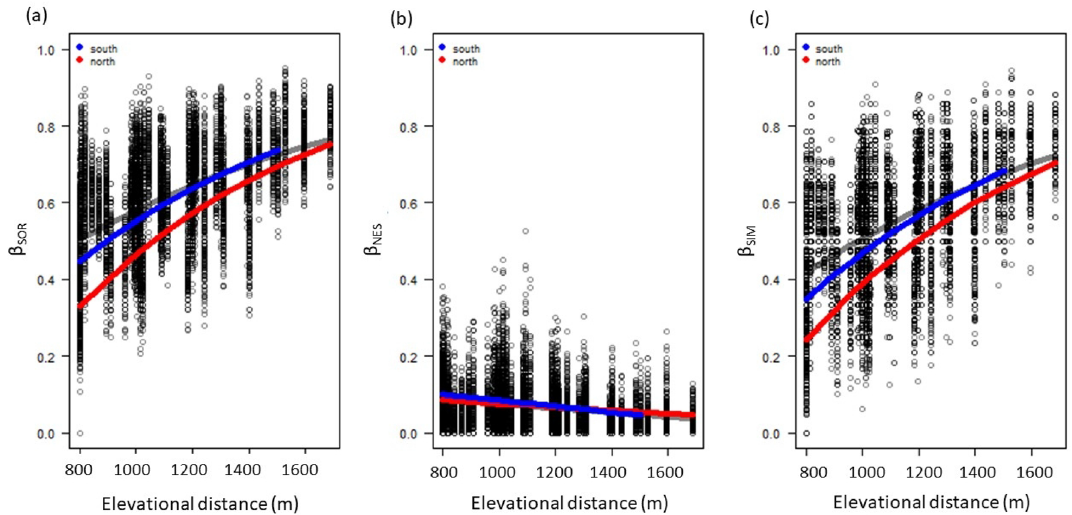
Figure 1. The relationship between ant species ( a ) total beta diversity, β sor ; comprised of its ( b ) nestedness- resultant component, β nes , and ( c ) turnover component, β sim for the Soutpansberg, South Africa. The red and blue lines represent the mixed model predictions for north and south aspects, based on data for all years, with each data point representing a comparison between the lowest elevation sites (810 m) and subsequent higher